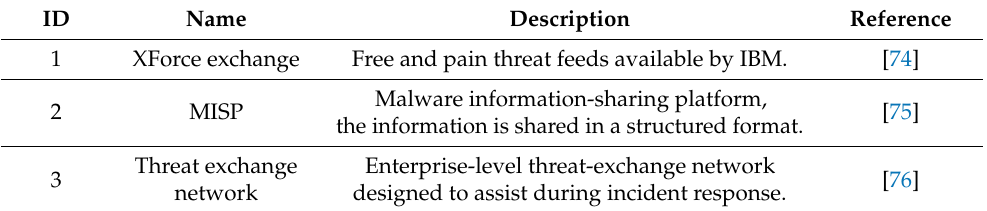
Table 18. Tools used for OSINT for open-source threat feeds.